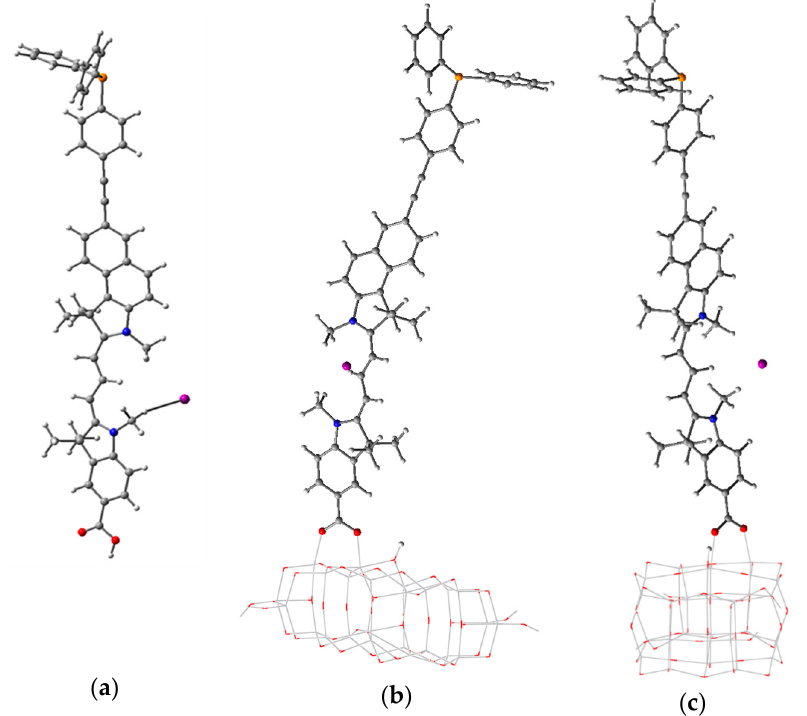
Figure 12. Optimized structures of the OMCD1 molecule ( a ) and the system OMCD1–Ti 24 O 50 H 4 , side view ( b ) and front view ( c ), calculated by DFT at the B3LYP/3-21G(d) level. Atom colors are: C, grey; O, red; N, blue; P, orange; I, purple; and H, light grey. Table 6. The structural parameters of the model system consisting of the Ti 24 O 50 H 4 clusters with an adsorbed OMCD1 molecule, and of the bare cluster, obtained after geometry optimization by DFT/B3LYP/3-21G(d) in vacuum. Geometrical parameters describing the adsorption modes: bond lengths (in Å), the torsion angle of the carboxyl group relative to the indoline plane, and the dihedral angle defined by the indoline plane and the plane of the three neighbor Ti atoms on the cluster surface (both in deg).